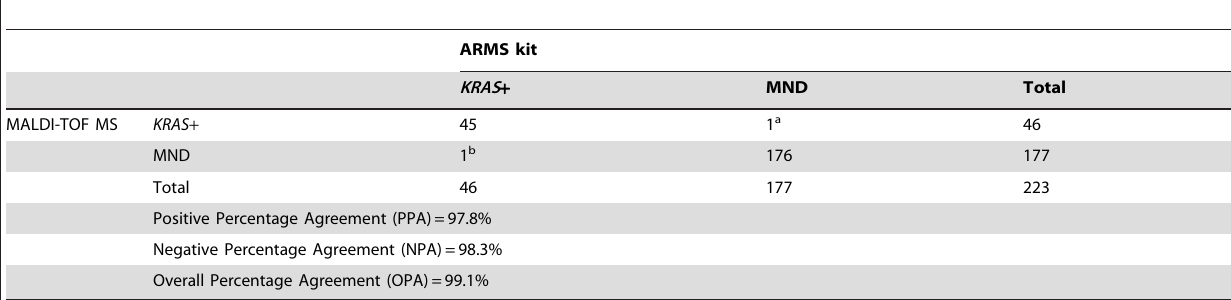
Table 4. Number of NSCLC samples in agreement between ARMS kit and MALDI-TOF in assays common to both kits.